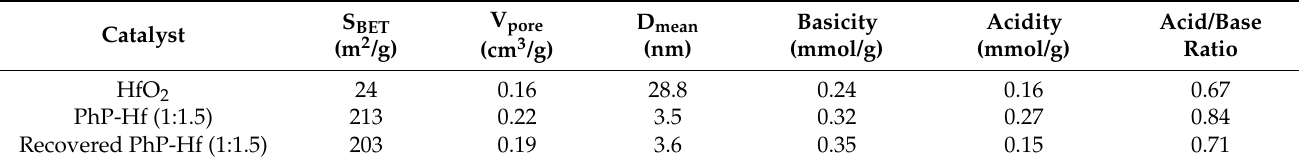
Table 1. Physical and acid-base properties of HfO 2 as well as fresh and reused PhP-Hf (1:1.5). Catalyst